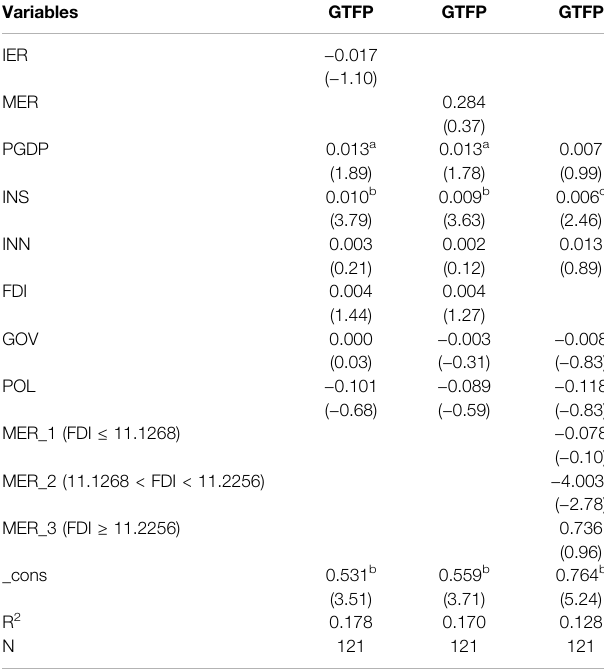
TABLE 8 | Empirical results of heterogeneity test in eastern China.